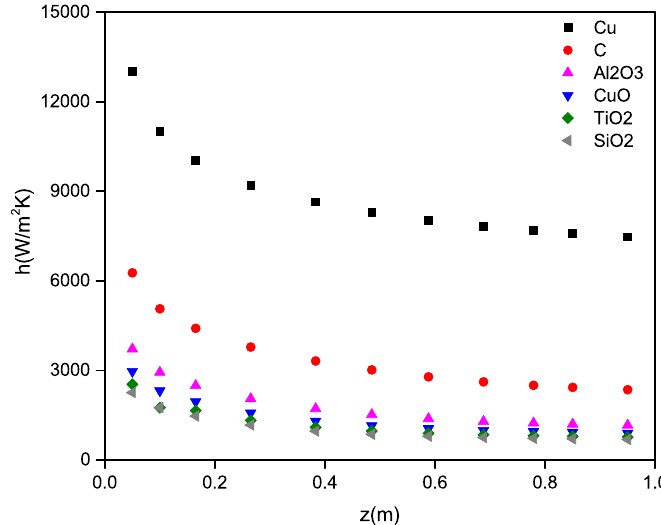
Figure 14. Axial variations of the local heat transfer coefficient h for six types of nanoparticles with d np = 42 nm, ϕ = 0.016 and Re =